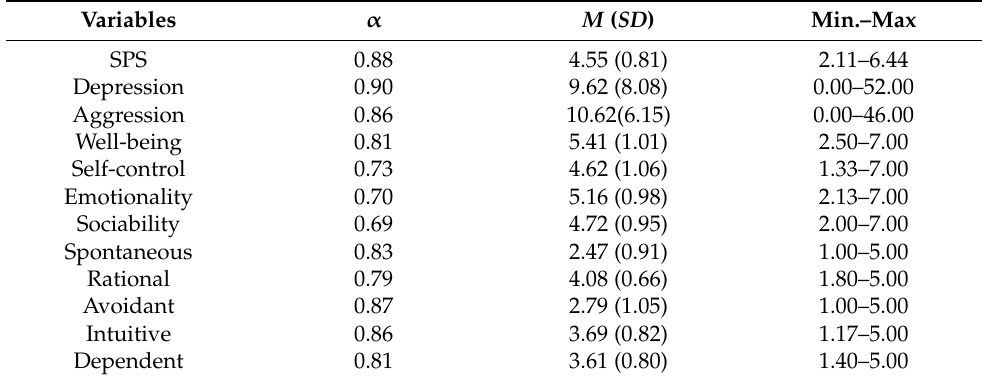
Table 1. Descriptive statistics and internal consistencies among variables.